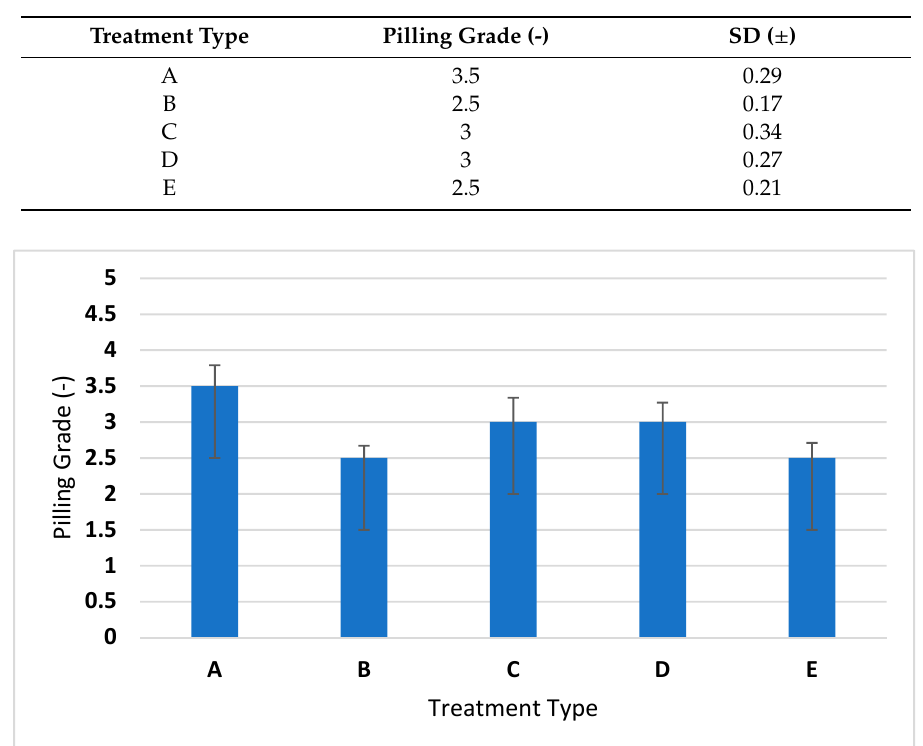
Table 4. E ff ect of finishes treatments on pilling grade. Table 4. Effect of finishes treatments on pilling grade .